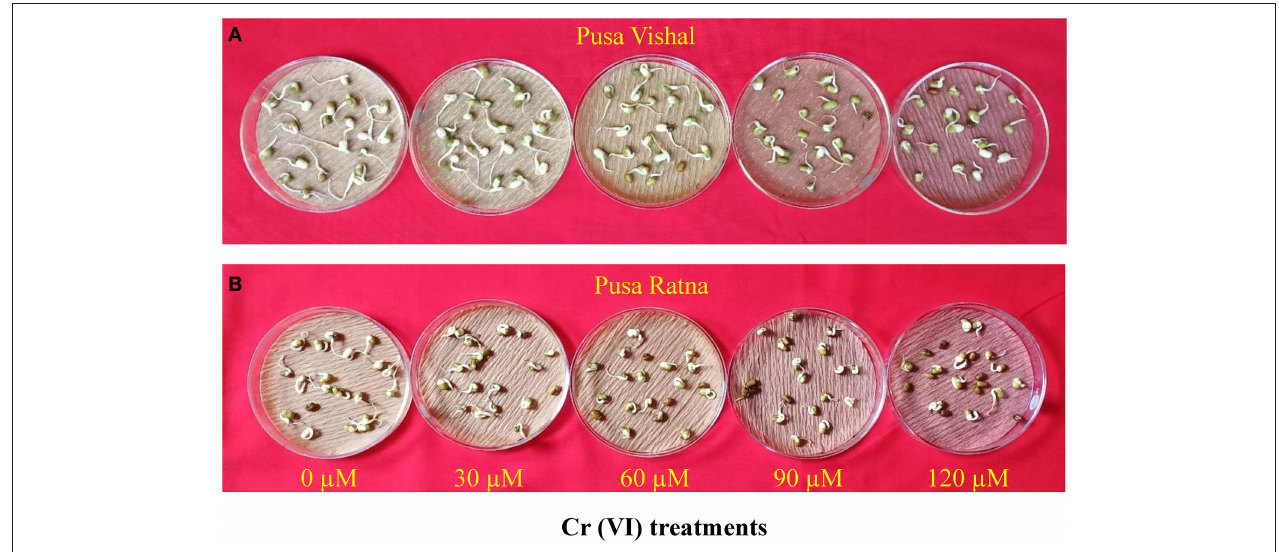
FIGURE 2 | Effect of different chromium (Cr [VI]) concentrations on seed germination in two Mungbean cultivars, (A) Pusa Vishal (PV) and (B) Pusa Ratna